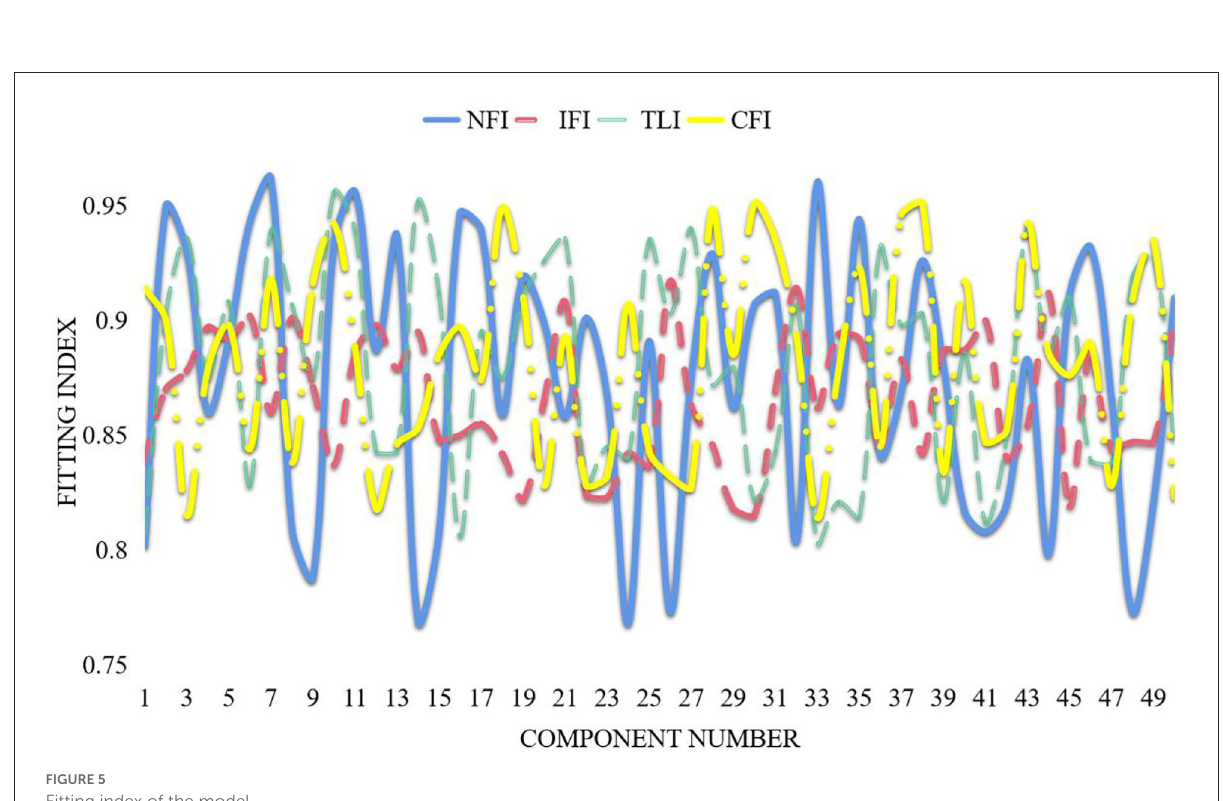
FIGURE5 Fitting index of the